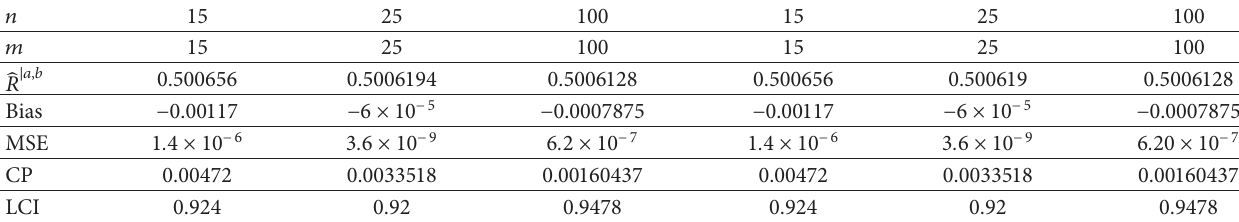
Table 2: Results for R | 1 , 3 � 0 . 5 and different values of sample sizes n and m